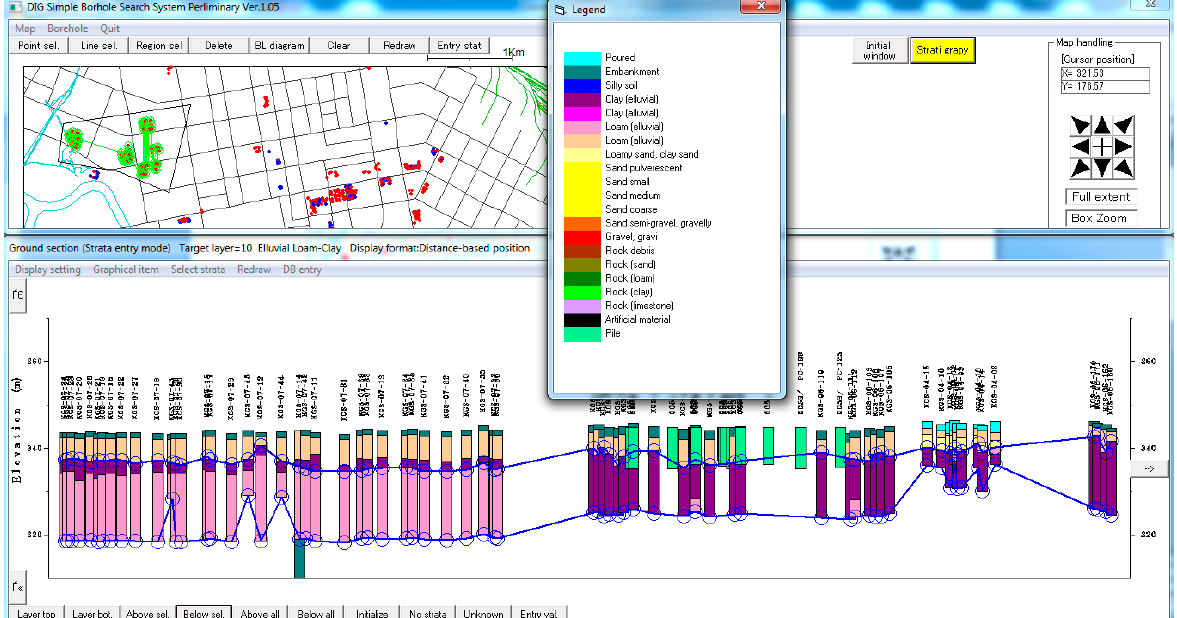
Figure 2. Obtaining a geologic cross section by the designated points.